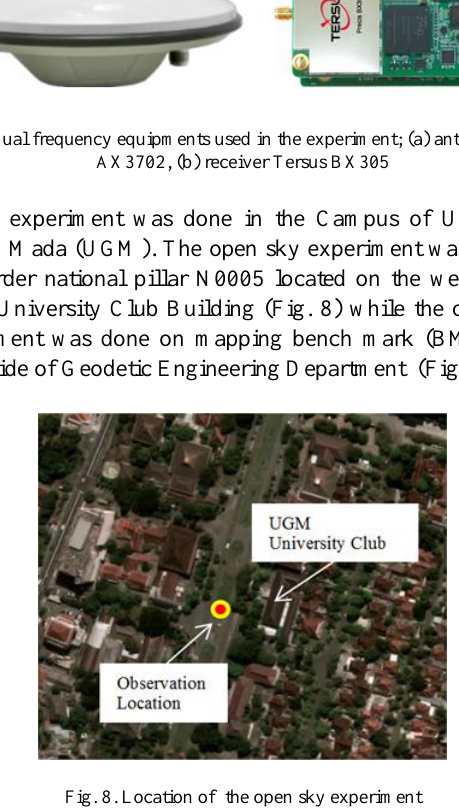
Fig. 8. Location of the open sky experiment Single frequency GPS module measurements are executed with Android smartphones using Geotagging+ applications while GPS dual frequency module measurements are conducted using Lefebure NTRIP Client and Mobile Topographer applications. Both of the receiver used in the experiment was powered up by using standard USB power Fig. 5. Research workflow bank. Example of complete set of equipments used for